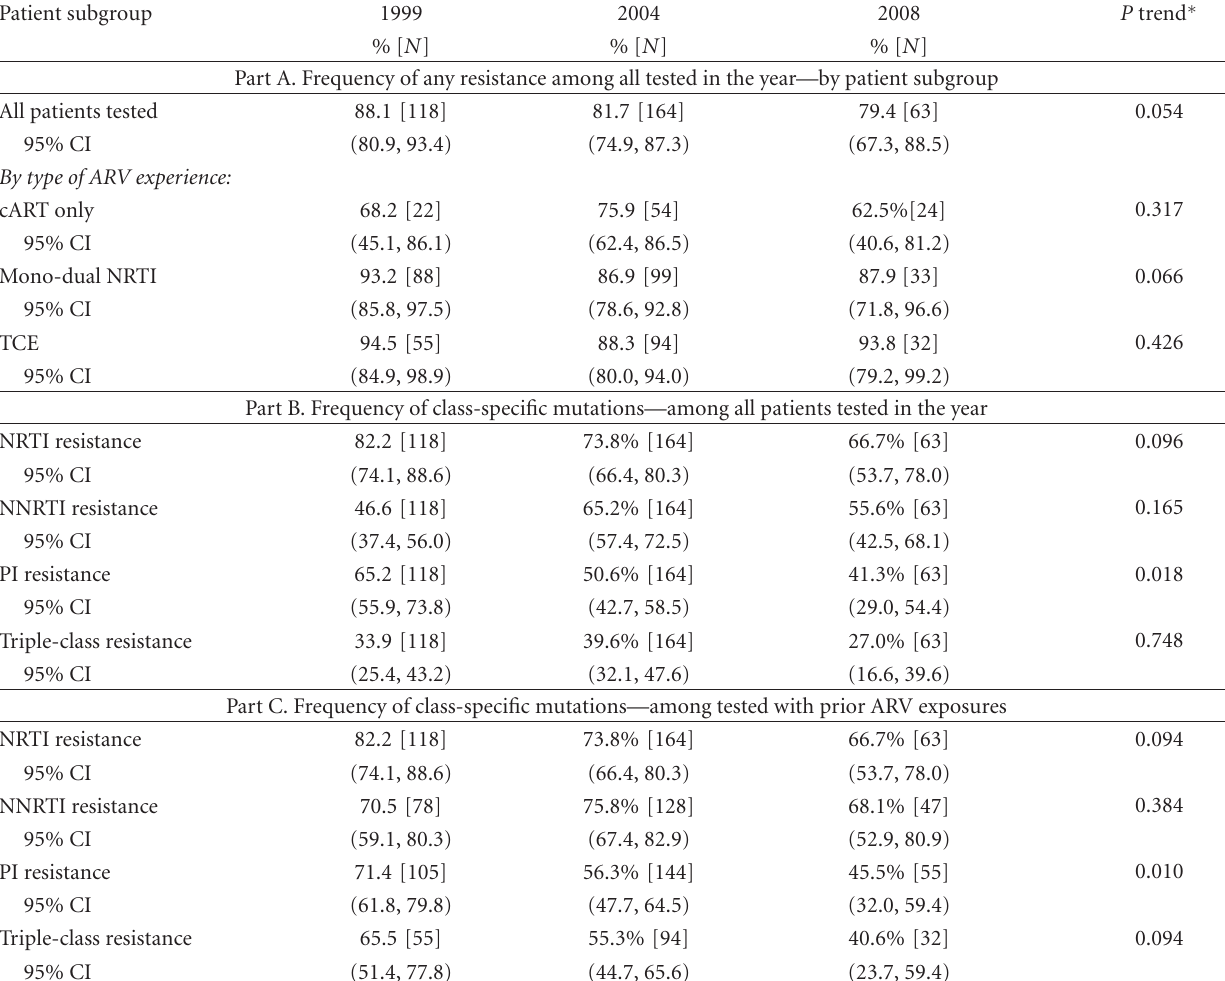
Table 2: Frequency of resistance mutations among ARV-experienced patients who had genotypic testing performed at viral load > 1,000copies/mL and while on ARVs, by year, the HIV Outpatient Study, 1999–2008. Patient